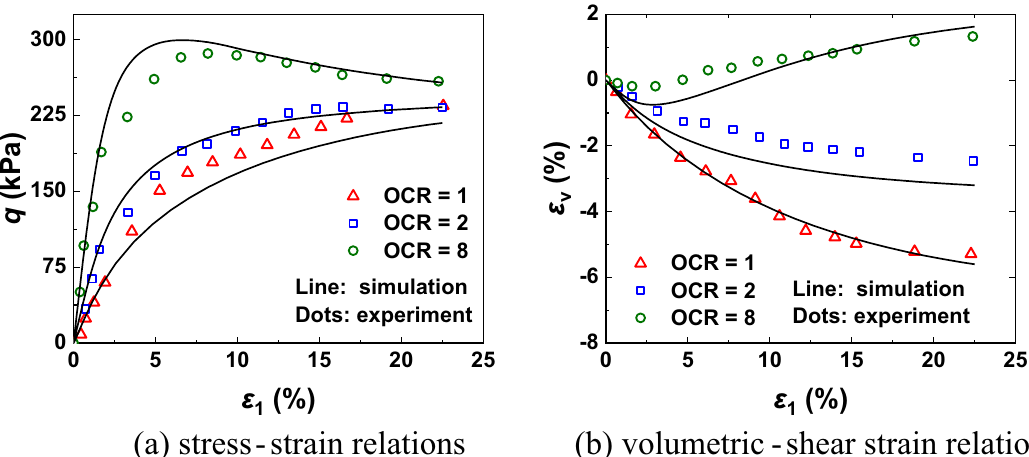
Figure 6. Model predictions and experiment results of Jiangxi clay under drained conditions.